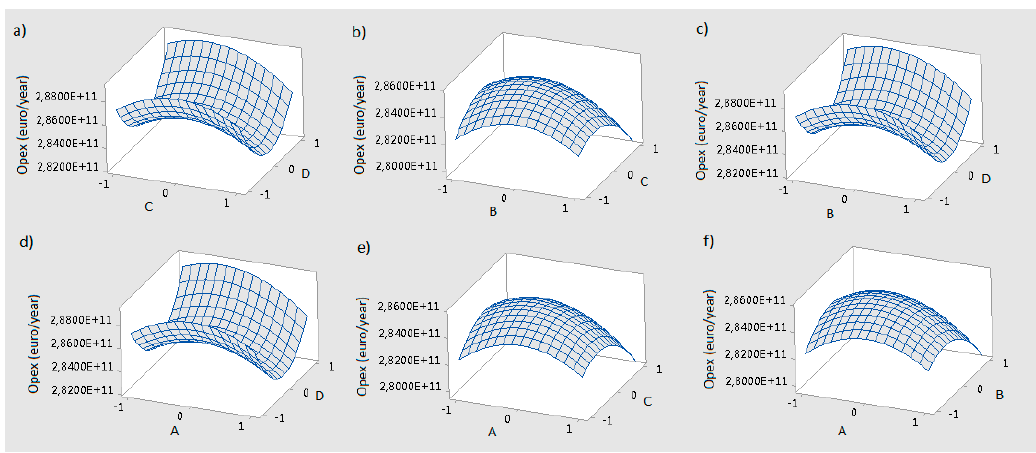
Figure 5. Response surface plots for CAPEX (€) as a function of: ( a ) factor C and D ; ( b ) factor B and D ; ( c ) factor B and C ; ( d ) factor A and D ; ( e ) factor A and C ; ( f ) factor A and B (Hold values: A = B = C = D = 0) (factor A = flue gas inlet temperature, factor B = column pressure, factor C = carbon dioxide composition in flue gas, factor D = height of the absorber).